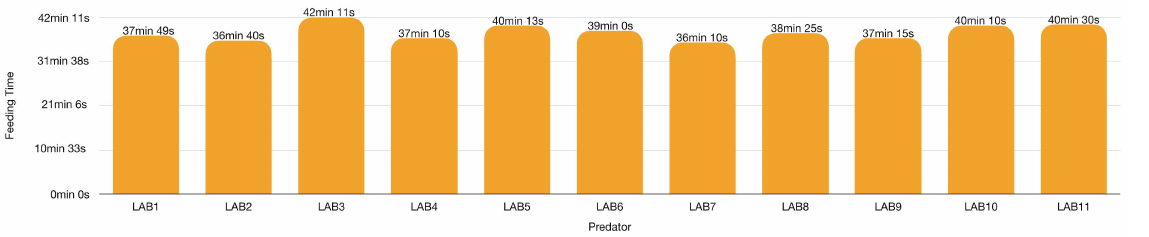
Figure 15. Zelus renardii feeding time in minutes recorded in 580 cm 3 arena each provided 10–12 prey, details in Table S4. Each bar represents the average time that Z. renardii took to feed on each prey item.